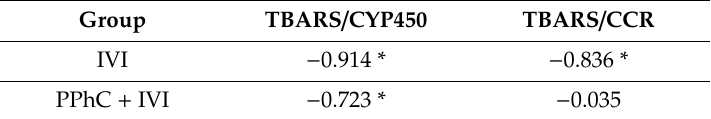
Table 3. Correlation coefficients between the parameters of oxidative stress (TBARS) and some parameters of drug metabolism in infected animals treated with PPhC (* p < 0.001).